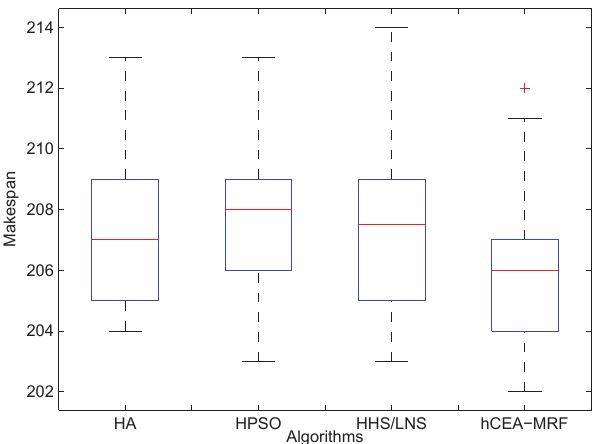
Figure 8. Box plot for makespan conducted on EMk10.